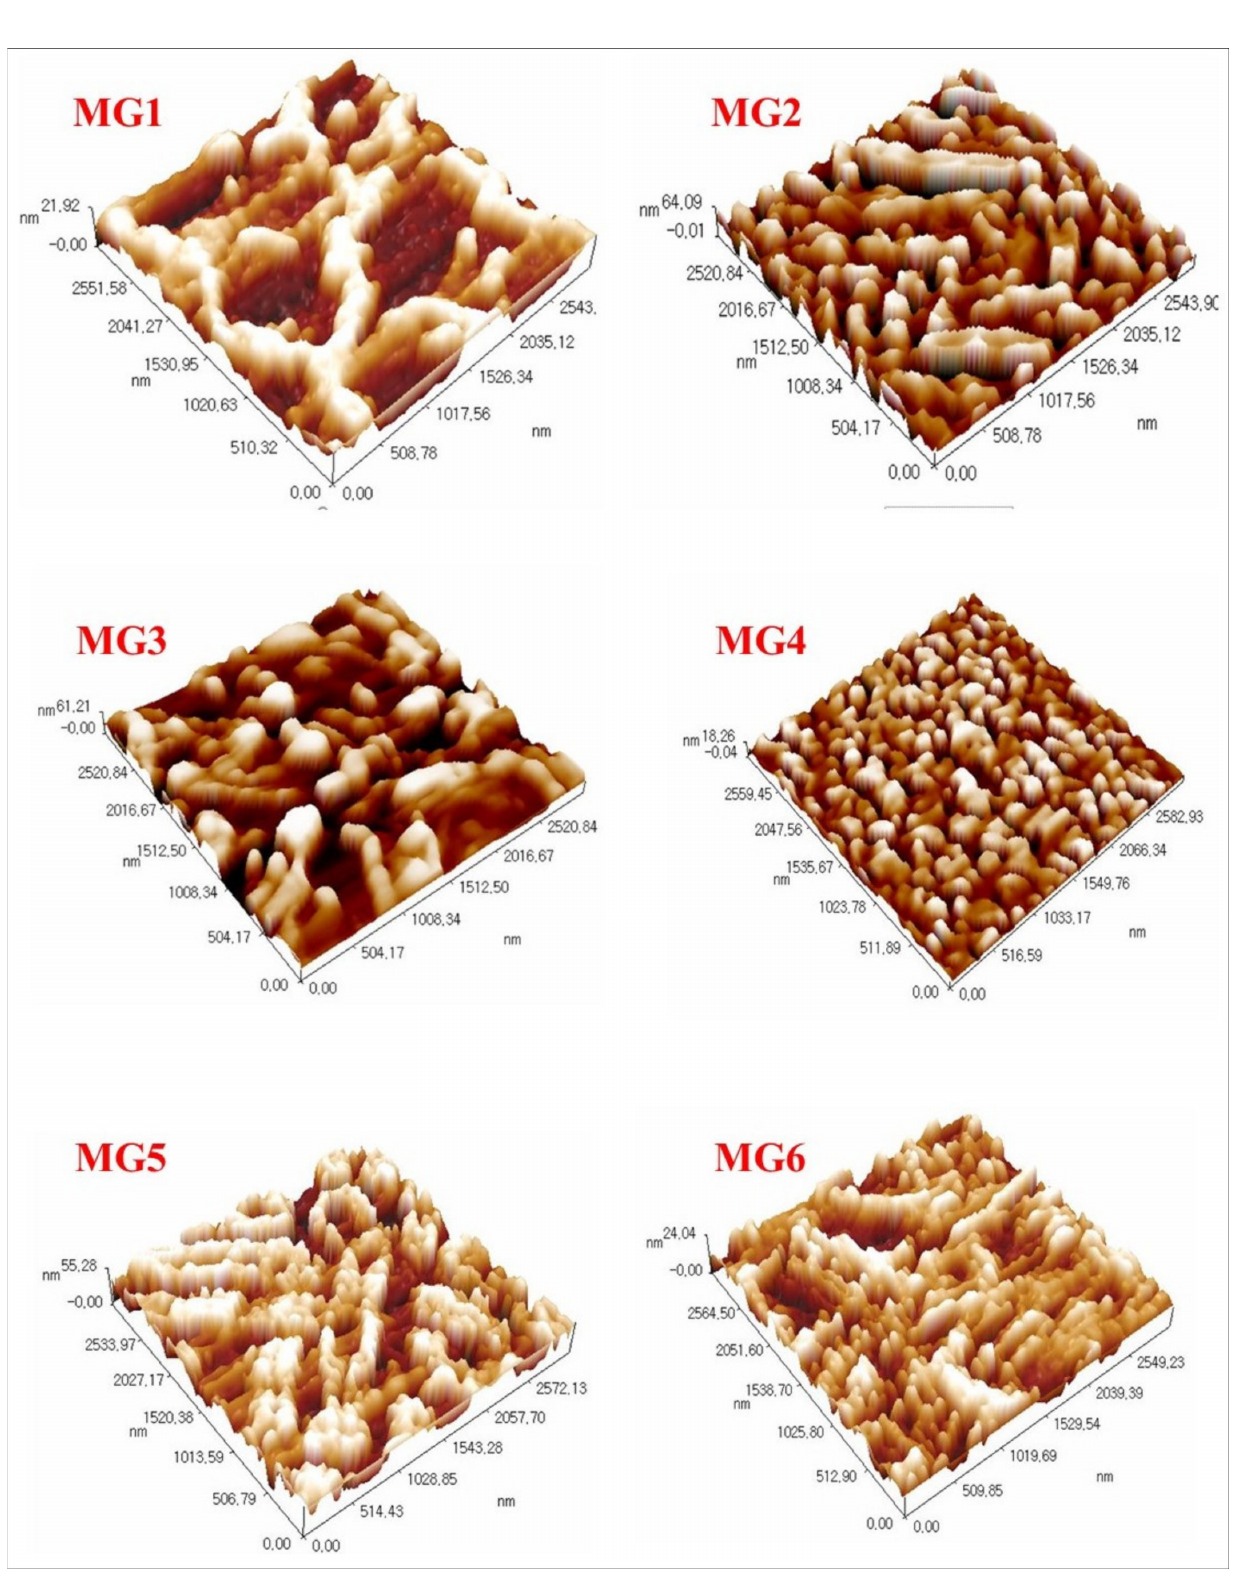
Figure 3. AFM images for the top membrane